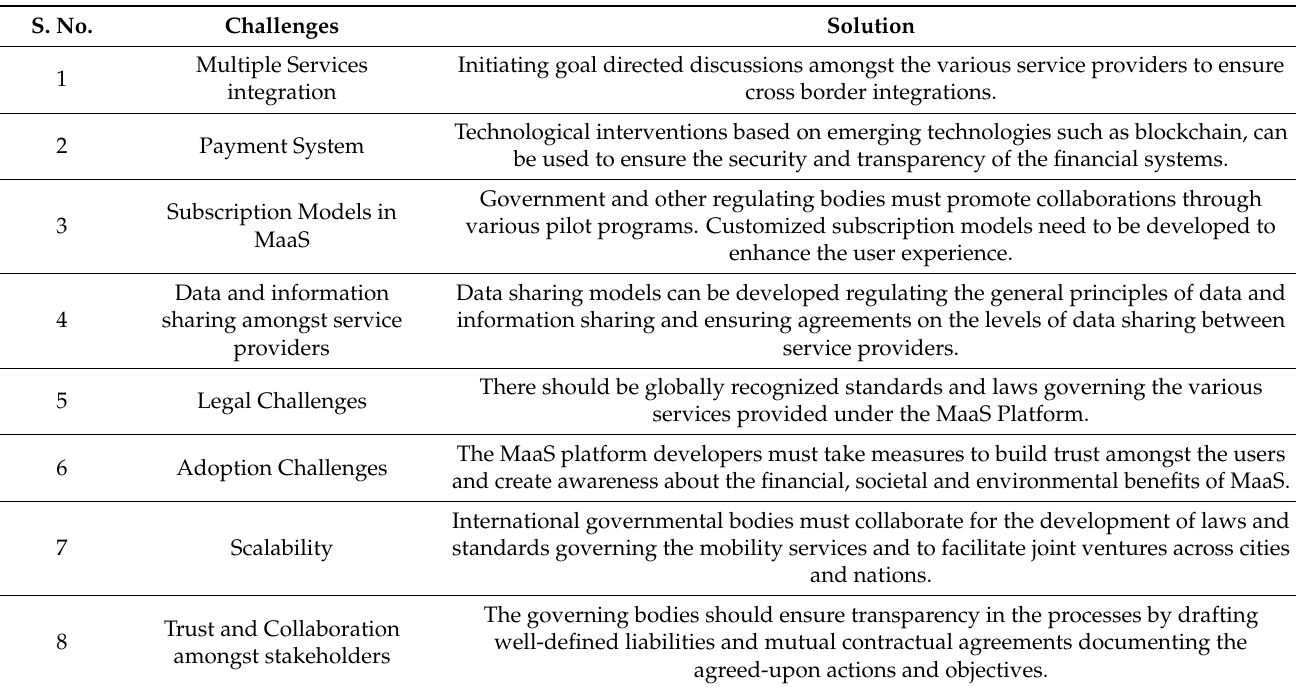
Table 3. Mobility as a Service (MaaS) implementation challenges and potential solutions. S.